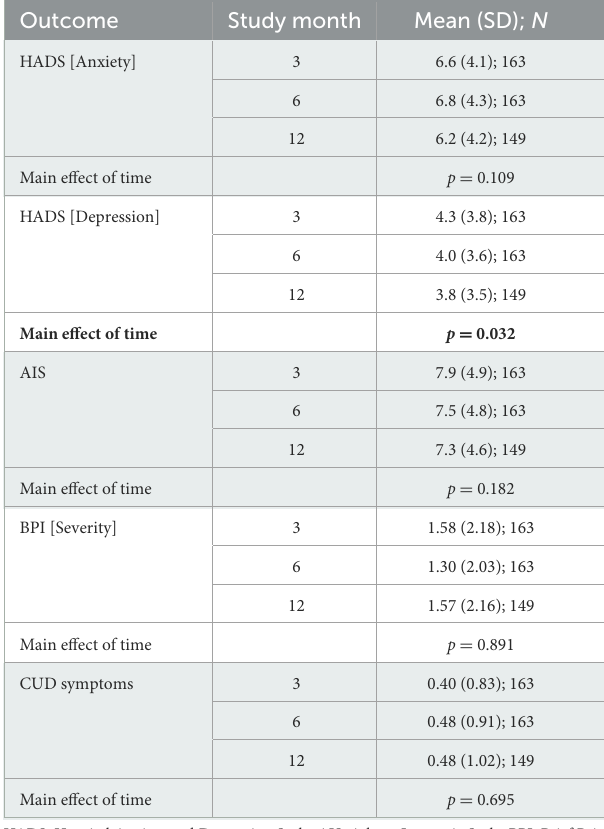
TABLE 2 Symptoms of insomnia, pain, depression, anxiety, and CUD during the 9-month post-randomization